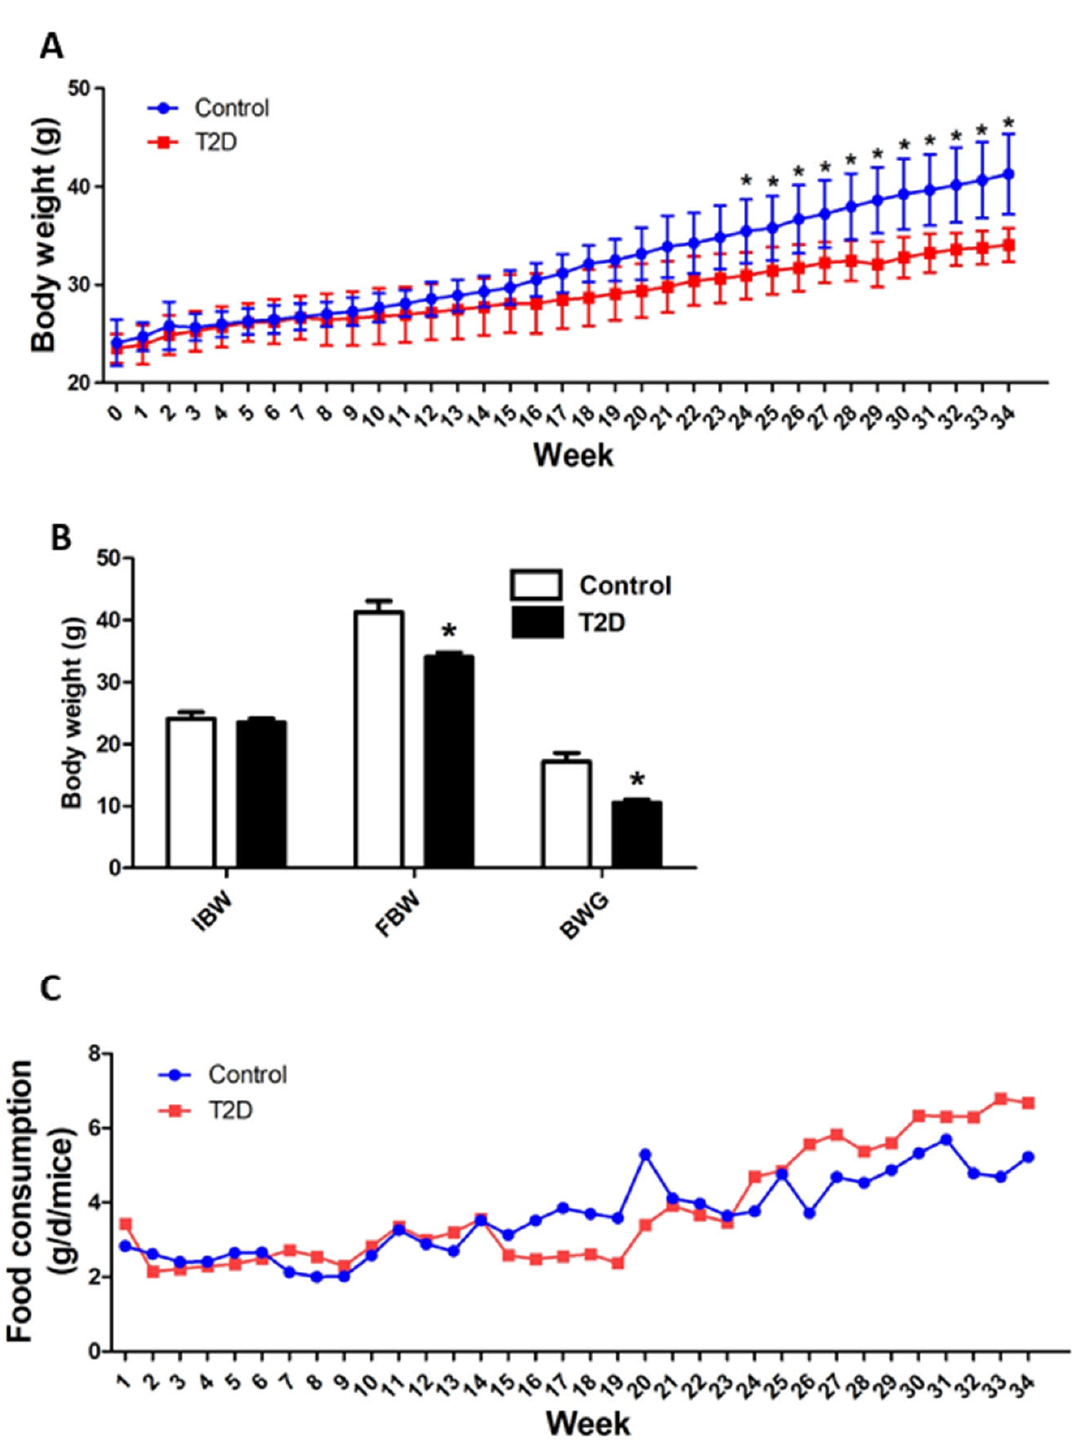
Figure 2. Animal growth and feed consumption. The body weight (BW) and feed intake of mice were monitored once a week. ( A ) The growth curve was plotted. ( B ) The initial body weight (IBW), final body weight (FBW), and body weight gain (BWG) were calculated. ( C ) The feed consumption throughout the experimental period was calculated. Data were statistically analyzed using the independent sample t-test in the SPSS 20.0 software. The result of feed consumption was not statistically analyzed because the five mice in each group were housed in one cage and the feed intake was recorded per cage. Results are presented as means ± S.D. of the samples from five ( n = 5) mice in each group. *: p < 0.05 vs.